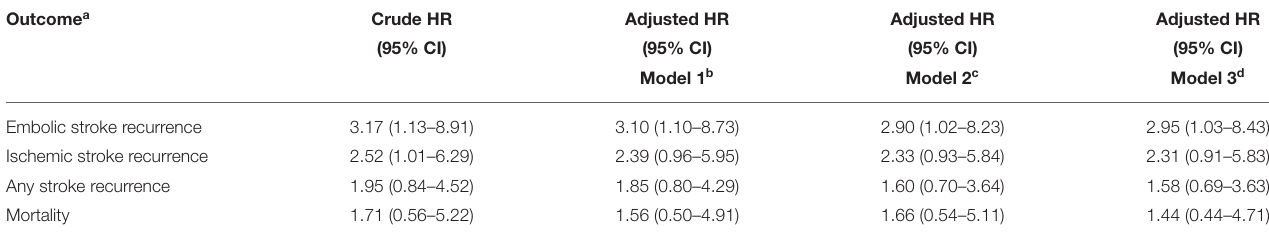
TABLE 3 | Univariate and multivariable Cox proportional hazards regression analyses investigating associations between non-chicken wing left atrial appendage morphology and outcomes. Outcome